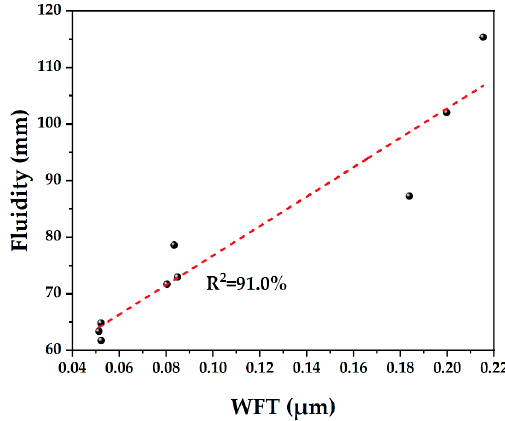
Figure 11. Fluidity versus water film thickness.